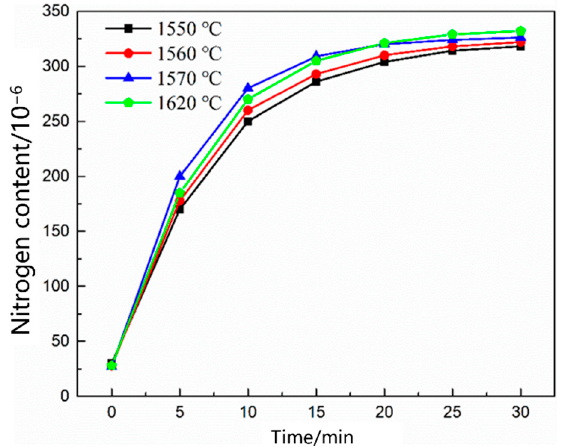
Figure 6. Change in the nitrogen content in the liquid steel at different temperatures.